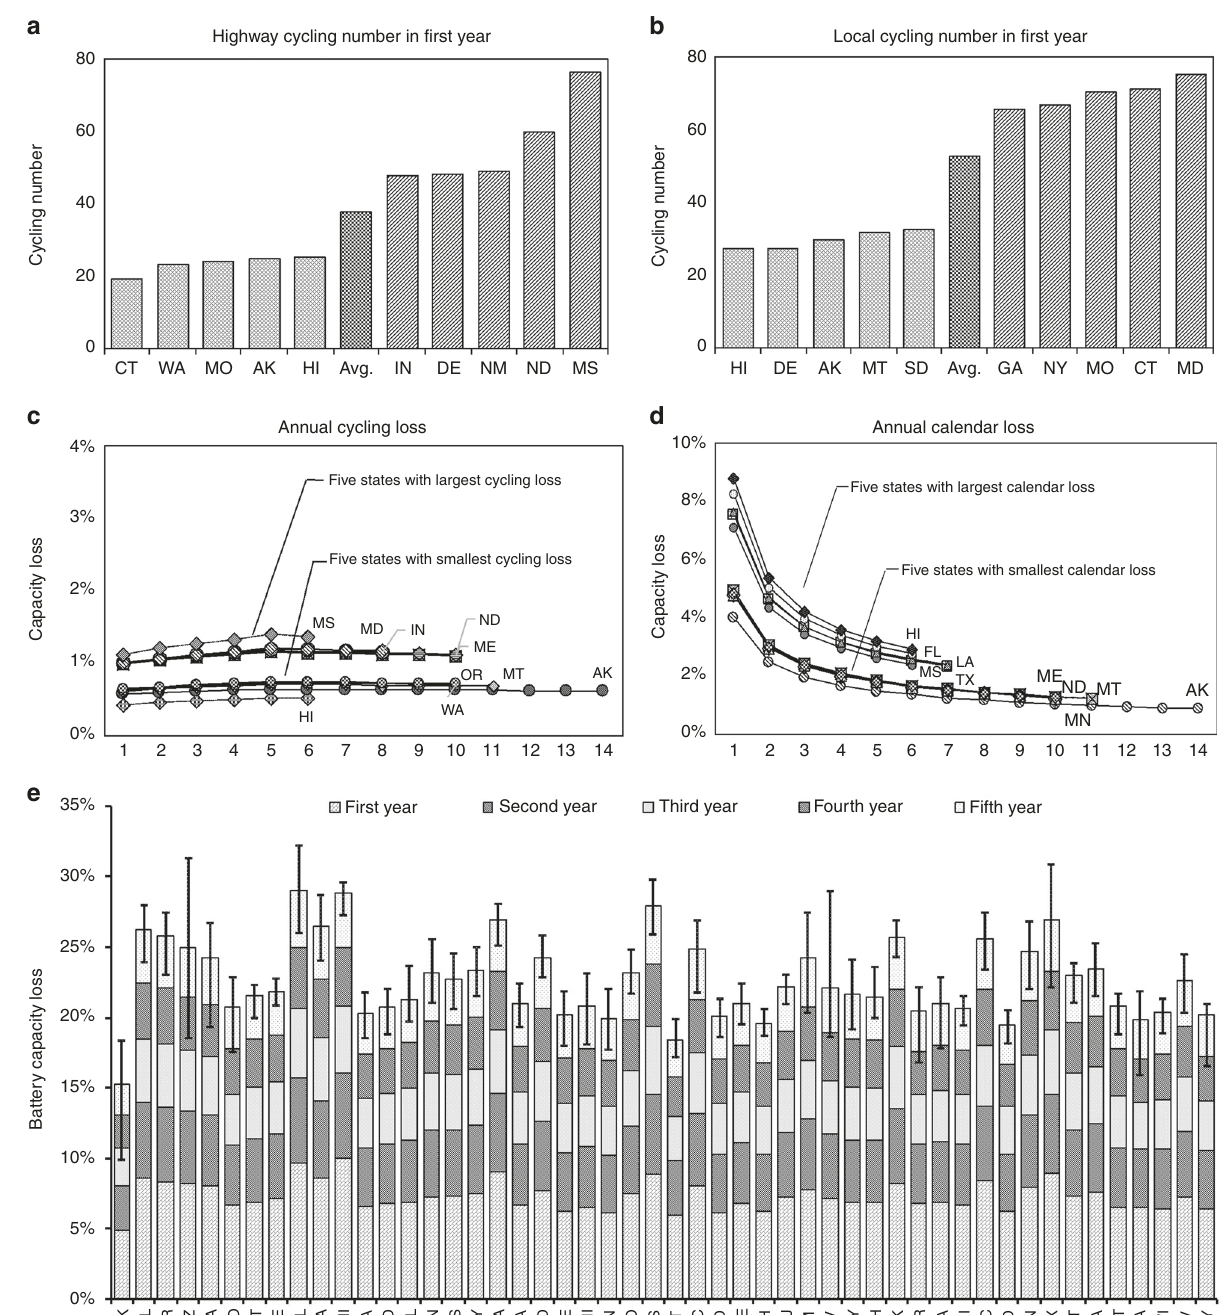
Fig. 2 Electric vehicle battery degradation and capacity loss in each state under actual operating conditions. a Top fi ve states, bottom fi ve states and the US average of battery cycling number needed for highway driving in fi rst year to meet the annual travel demand. b Top fi ve states, bottom fi ve states and the US average of battery cycling number needed for local driving in fi rst year to meet the annual travel demand. c Top fi ve and bottom fi ve states for battery annual cycling capacity loss throughout battery life under actual driving conditions, ranging between 0.4% in Hawaii and 1.6% in Mississippi. d Top fi ve and bottom fi ve states for battery annual calendar capacity loss during the battery life under each state ’ s ambient temperature and aging time, ranging between 9.6% in Hawaii and 1% in Alaska. e Annual and total battery capacity loss during 5-years operation in each US state under average driving conditions, ranging between 15% in Alaska and 28.7% in Florida. Error bars show the ranges of the battery capacity loss under varying ambient temperatures,